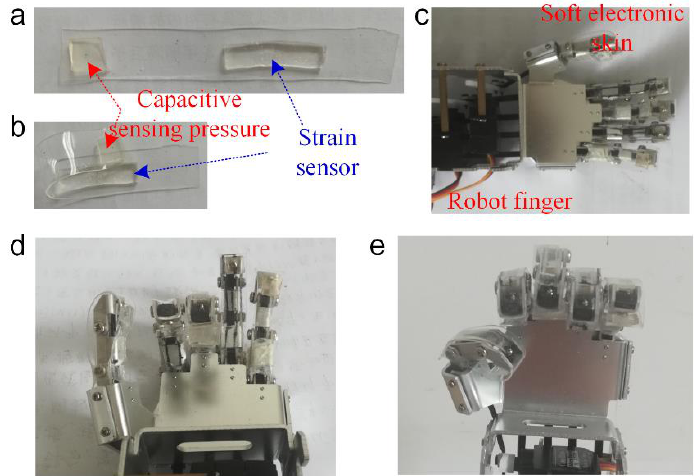
Figure 3. Integration of RES to the robot finger. Optical image of ( a ) RES on the PDMS substrate. ( b ) RES bending to the finger-compatible shape. ( c ) The robot finger with RES. ( d , e ) Optical images of the different bending actions of the robot finger with RES.